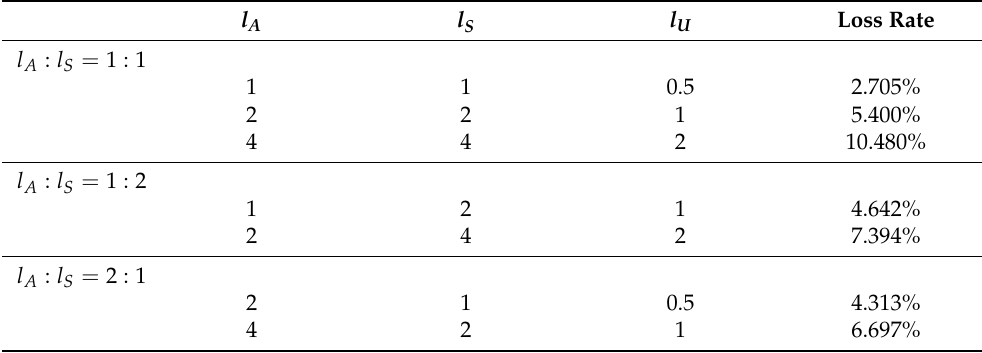
Table 15. Storage loss of the leaf layout when the ratio of the picking aisle width to the shelf width is certain. l